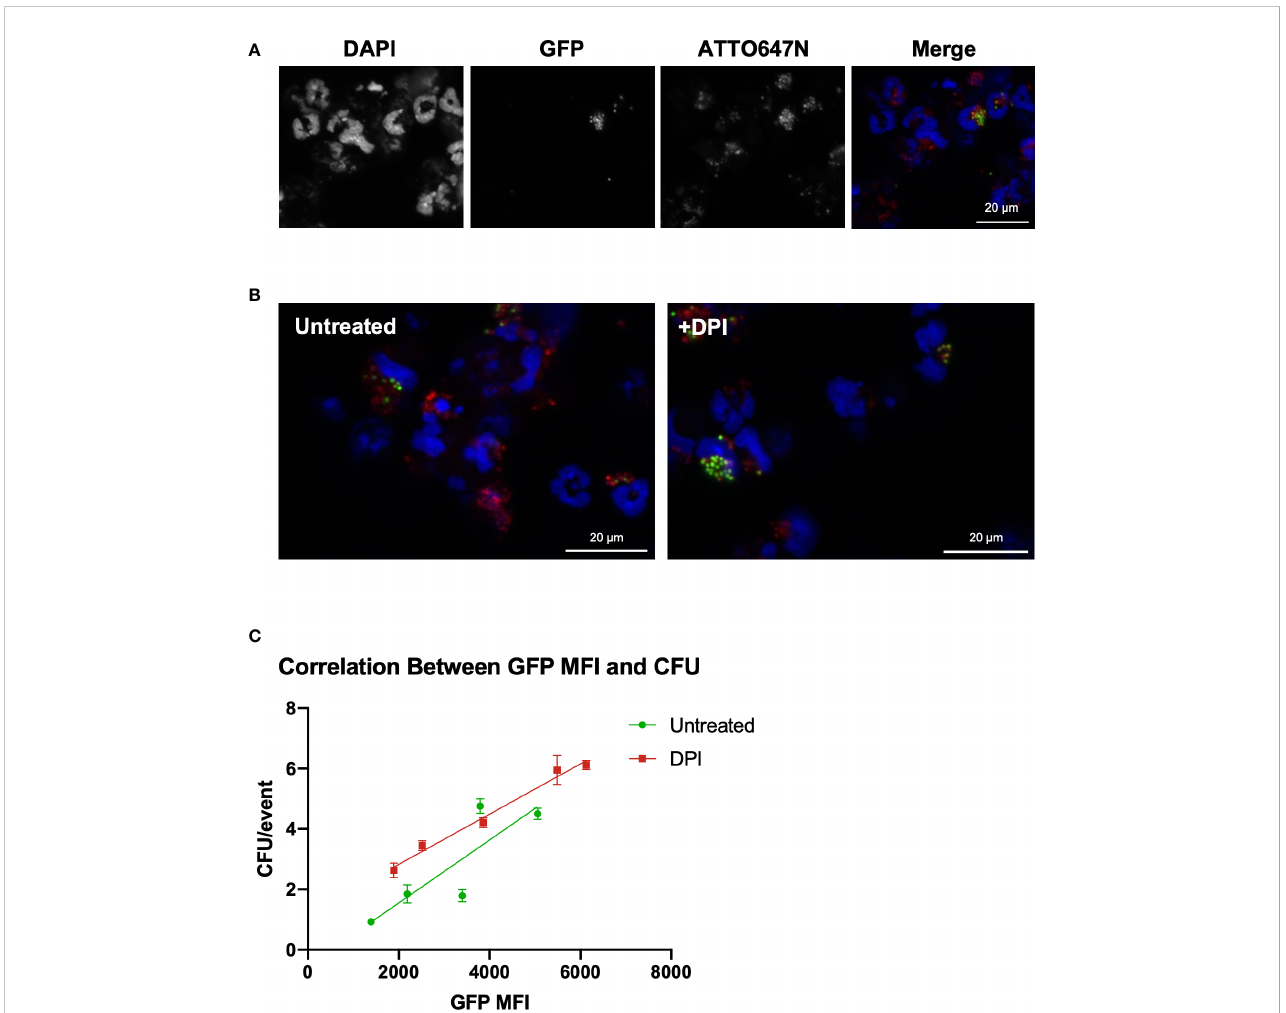
FIGURE 3 GFP fl uorescent intensity correlates with the number of viable internalized S. aureus cocci. (A) Imaging of HB8 neutrophils after 2 hours of killing in vitro (40x). (B) GFP/ATTO647N merged images for untreated and DPI treated HB8 neutrophils (40x). (C) Correlation between GFP MFI and viable intracellular bacterial burden (CFU representative of plating lysate in